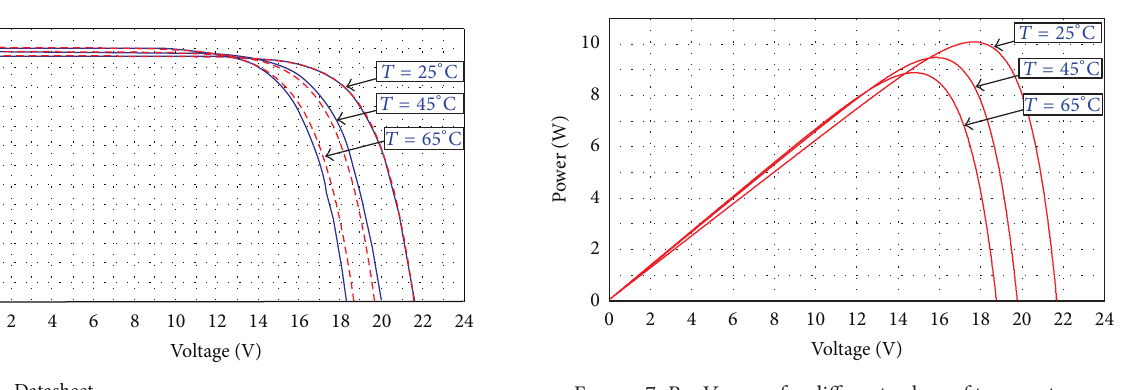
Figure 7: 𝑃 × 𝑉 curve for different values of